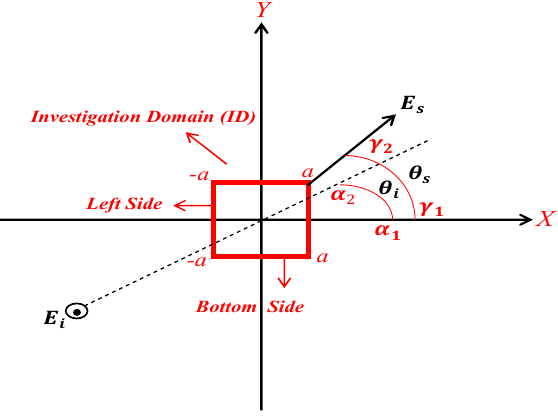
Figure 6. Comparison between the actual PSF (solid lines) and the approximation 𝑃𝑆𝐹(cid:3562) (dotted lines) for three modes for 𝜙 (cid:2868) = 0 (red lines), 𝜙 (cid:2868) = 𝜋 6⁄ (blue lines), 𝜙 (cid:2868) = 𝜋 4⁄ (green lines) and 𝜙 = 𝜋 2⁄ (cyan lines). (cid:2868)